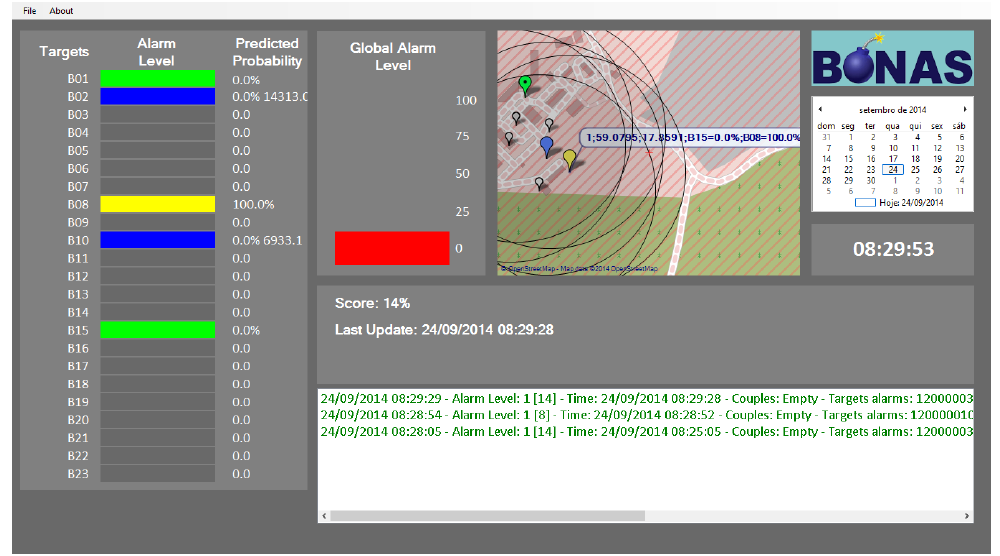
Figure 7. Example of user interface obtained during the test campaign at FOI, which shows the positive detections for three targets obtained by two sensors. No couples of targets are known to be used together in the preparation of one IE.